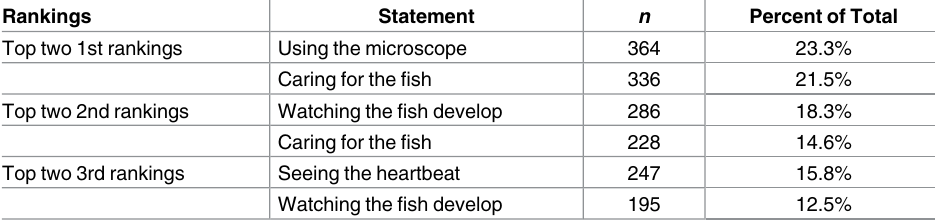
Table 3. Students’ favorite parts of the